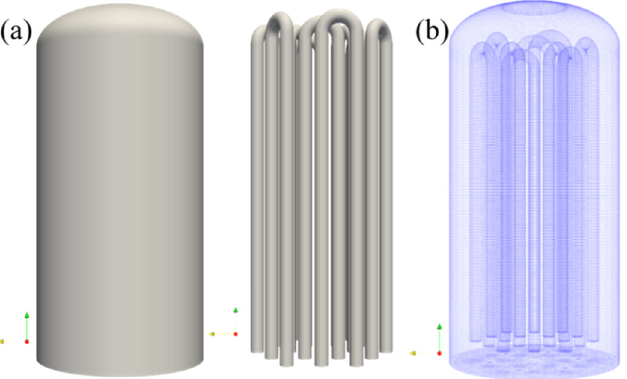
Figure 2. Schematic diagram of furnace body and silicon rods: ( a ) 3D models; ( b ) grid structure.